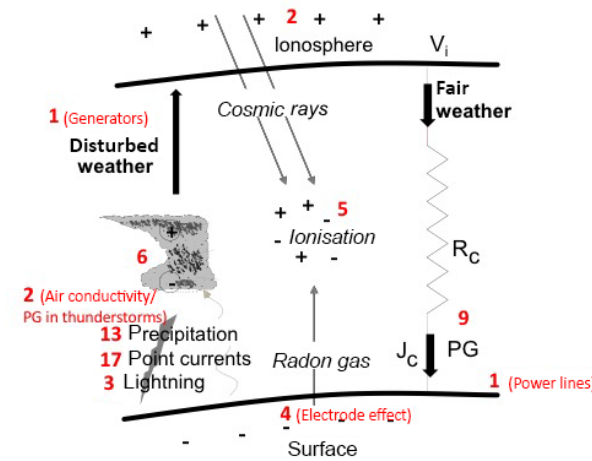
Figure 2. Concepts in atmospheric electricity (AE) (following Har- rison et al., 2015), with the number of papers published by Chalmers on each topic indicated in red. Potential gradient is abbreviated to PG, Rc the columnar resistance and Vi the ionospheric potential in the global electric